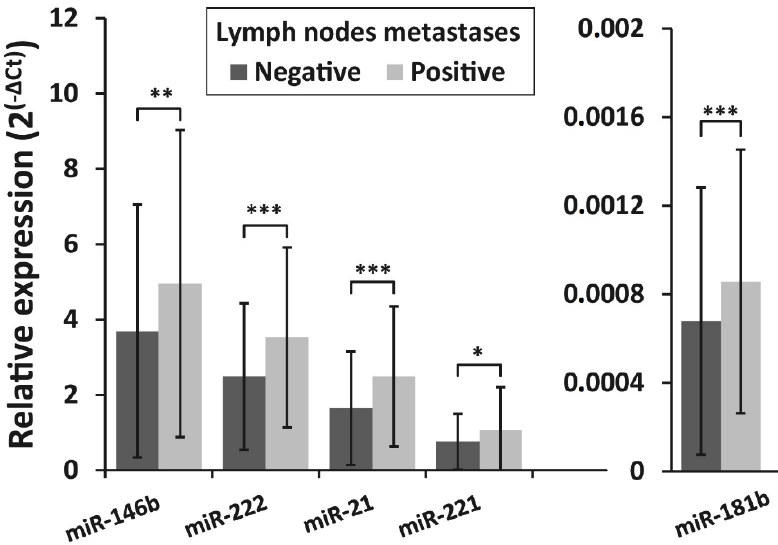
Figure 4. Relative expression levels of miR-146b, miR-222, miR-21, miR-221, and miR-181b in PTC in patients with lymph node metastases at initial surgery and patients without metastases. All data are presented as the mean ± SD. * p < 0.05, ** p < 0.01, and *** p < 0.001.